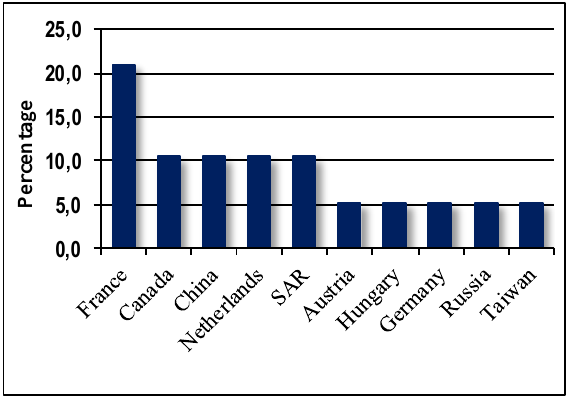
Figure 15. Countries that made major contribution in research related to usage of SAR / inSAR, LiDAR, and Radars in remote sensing